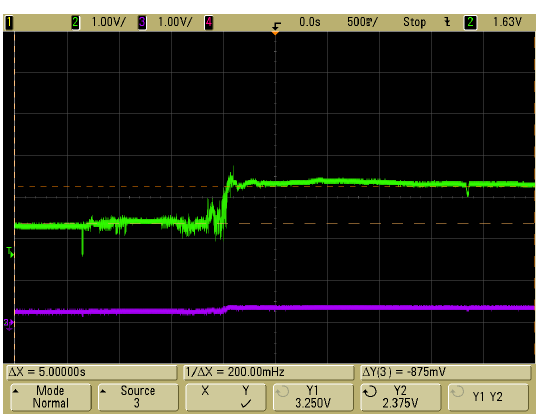
Figure 15. Response when the weights were